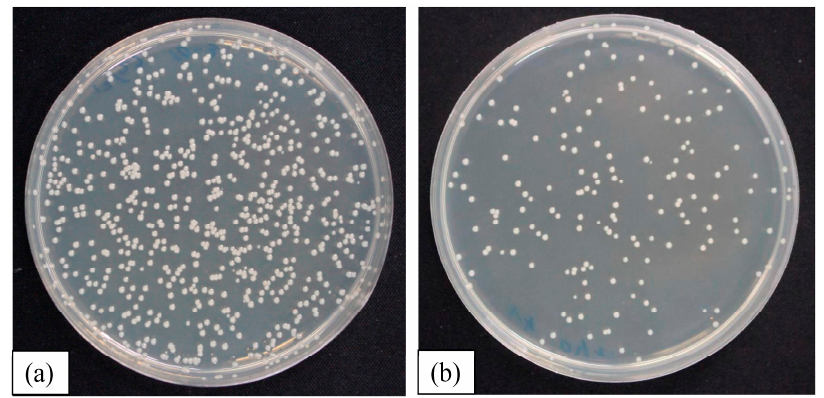
Figure 9. Typical photographs of visualized colonies on the agar plates after incubation for 24 h on ( a ) uncoated SS316L; and ( b ) CNx-Zr coated samples.